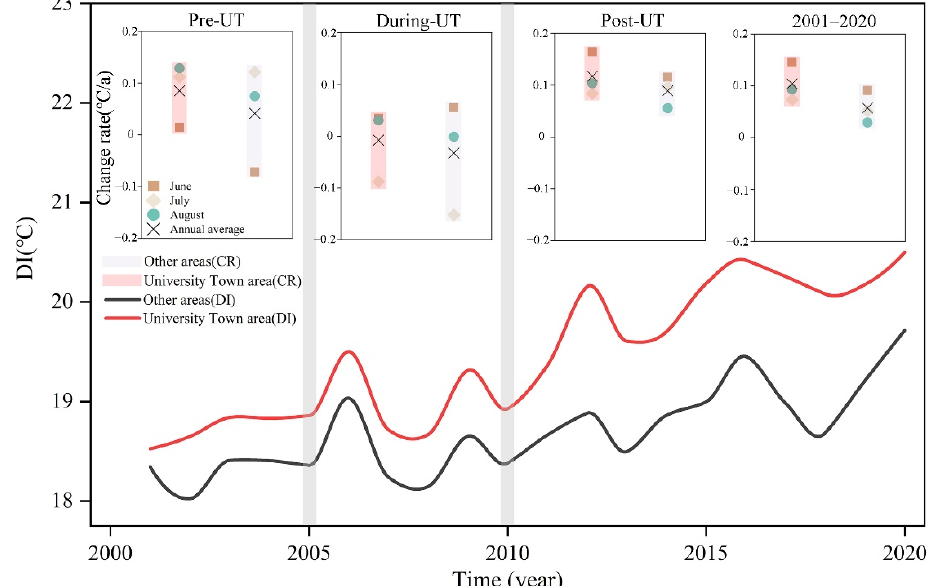
Land 2022 , 11 , 688 Figure 5. DI change trends in University Town and other areas in Chenggong. Figure 5. DI change trends in University Town and other areas in Chenggong.